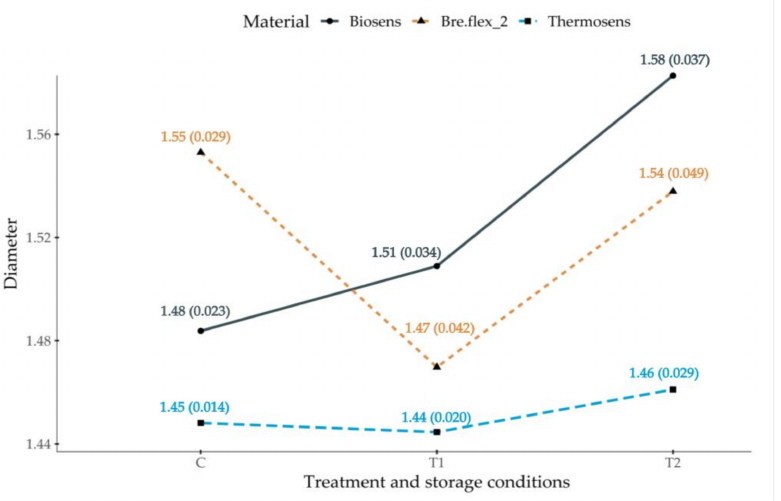
Figure 3. Treatment and storage conditions, and material as diameter predictors. Mean and standard deviation values in brackets () are presented for each group.